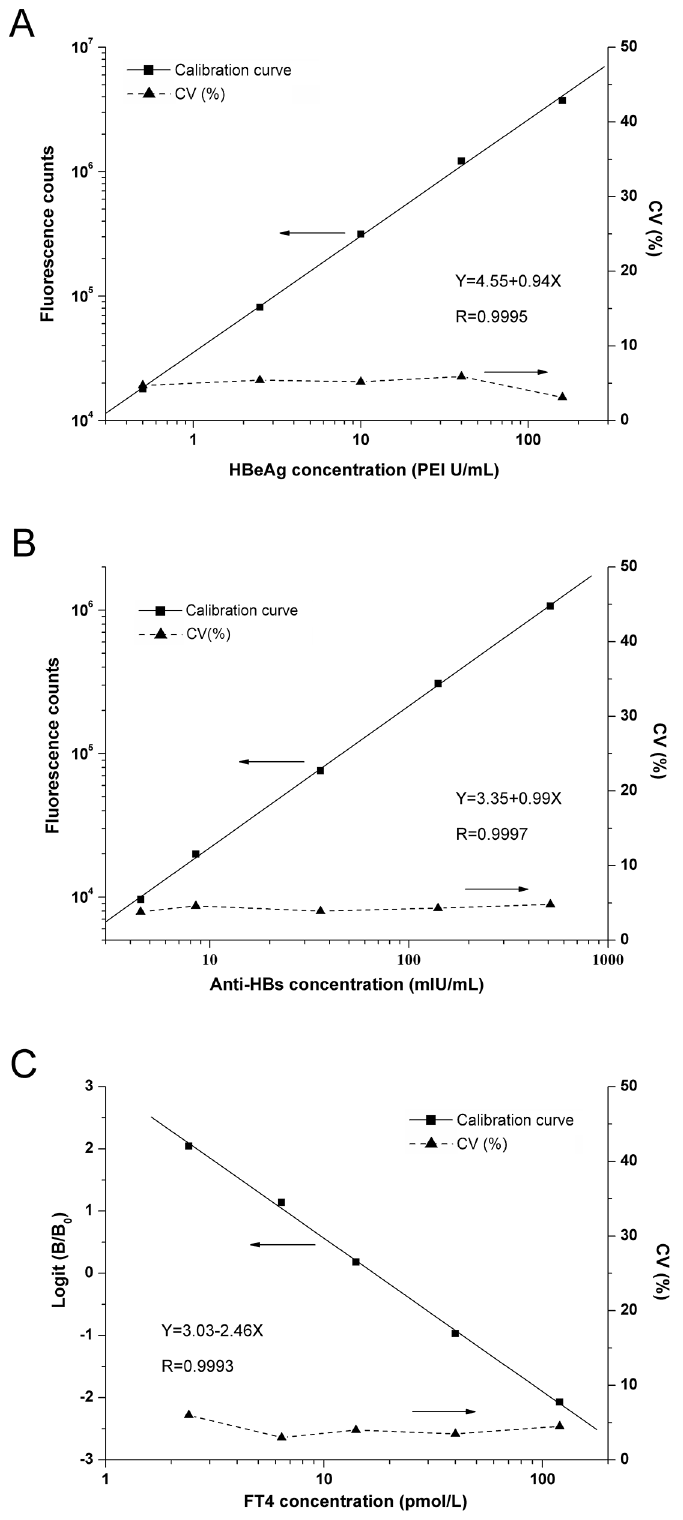
Fig 2. Calibration curves for MMPs-TRFIA for determinations of HBeAg (A), Anti-HBs (B) and FT4 (C) standards. Fluorescence intensity and standard deviations were calculated from a set of five measurements.